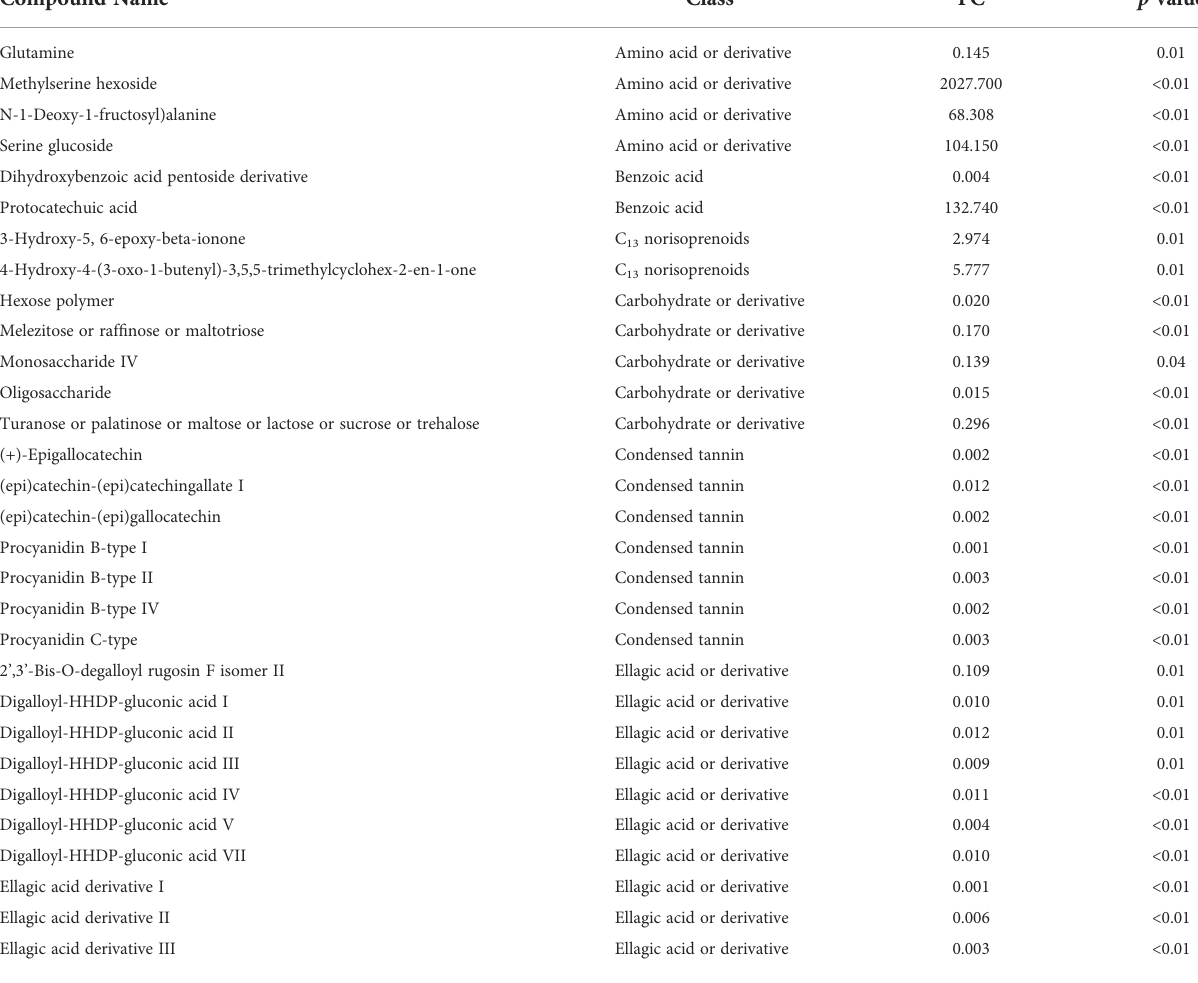
TABLE 1 Results of the ANOVA test for the evaluation of the effect of the leaf pre-processing in extracts prepared with leaves from young and mature trees [ p < 0.05; FC < -2: higher content in the fresh leaf extract (FLE); FC > 2: higher content in the dried leaf extract